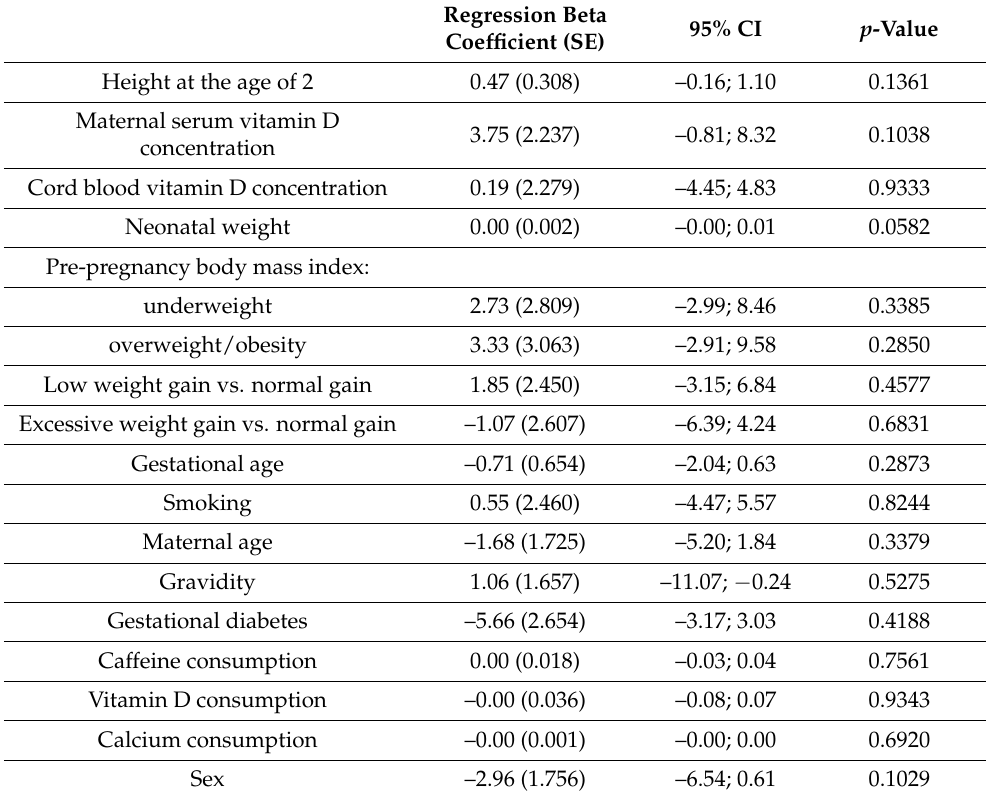
Table 5. Relationship between selected parameters and height at the age of